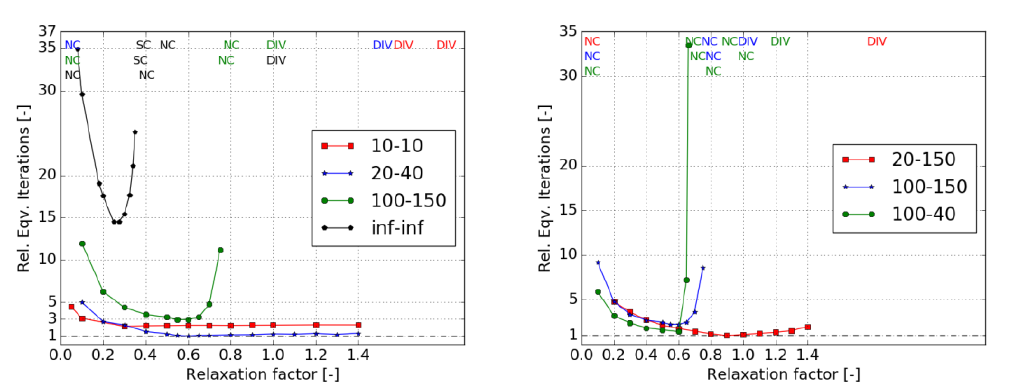
Figure 4: Effect of the damping on the convergence of the algorithm for different limitations on the iteration numbers per call. The labels follow the definition given in the current paragraph. DIV stands for divergent behavior, NC for non-convergent trend, SC for slow